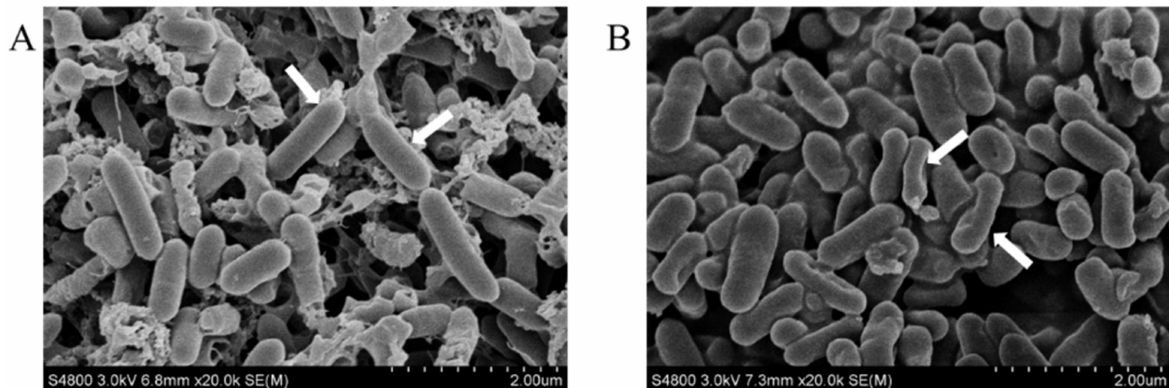
Figure 3. Morphological changes of L. monocytogenes treated by SAEW(slightly acidic electrolyzed water): ( A ) Control SEM image and ( B ) SAEW treatment SEM image. SAEW with ACC(available chlorine concentration) of 6.03 ± 0.13 and pH of 5.76 ± 0.03 was used for 60 s in the